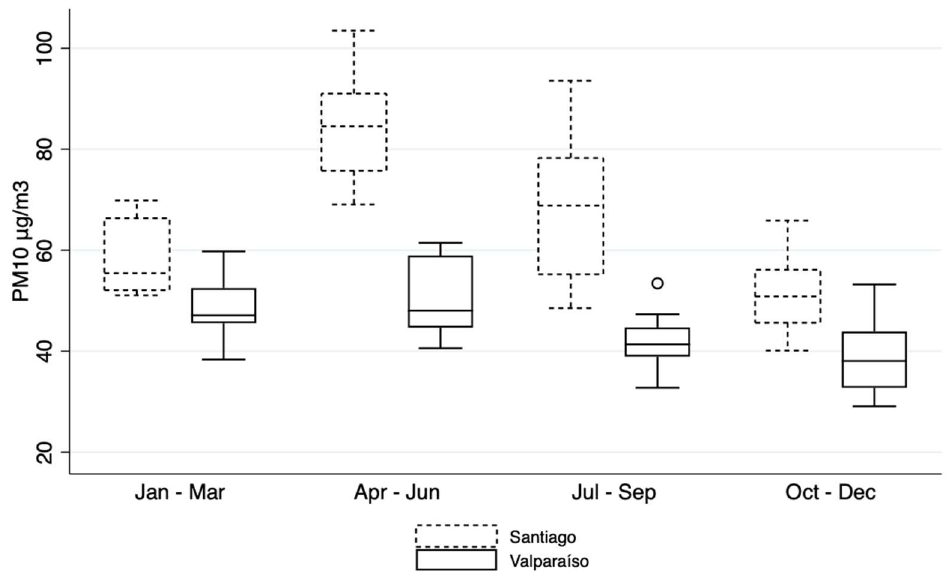
Figure 3. Temporal trend of the Particulate Matter (PM 10 ) by trimester in the Valparaíso and Santiago regions from January 2010 to December 2013.